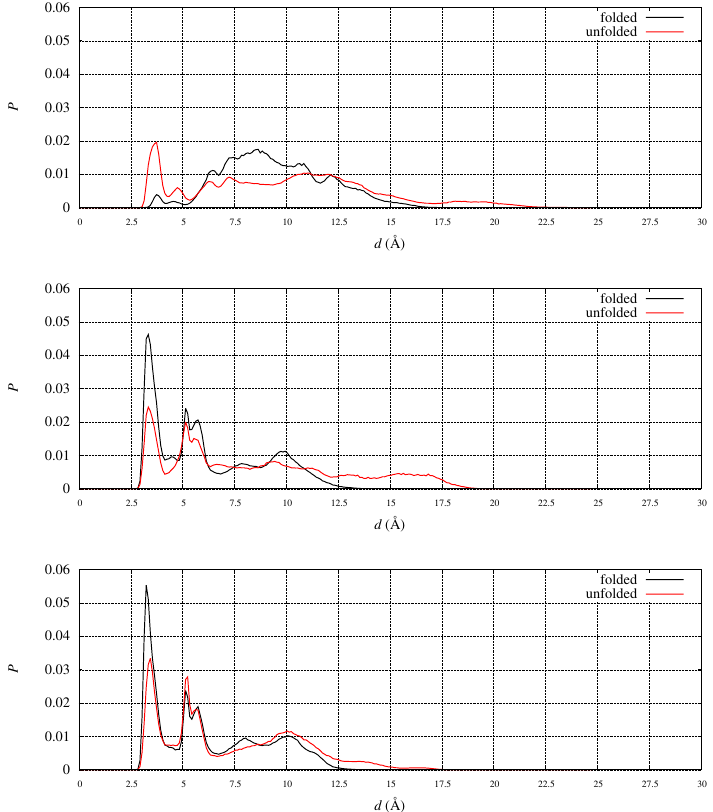
Figure 9. Distribution of selected distances in folded (CV = 14, black curve) and unfolded (CV = 4, red curve) states. Top— d is the distance between N η (Arg 97) and C γ (Asp 104), WT sequence; middle— d is the distance between N η (Arg 97) and C δ (Glu 100-101), WT sequence; bottom—same as in the middle, for D104G